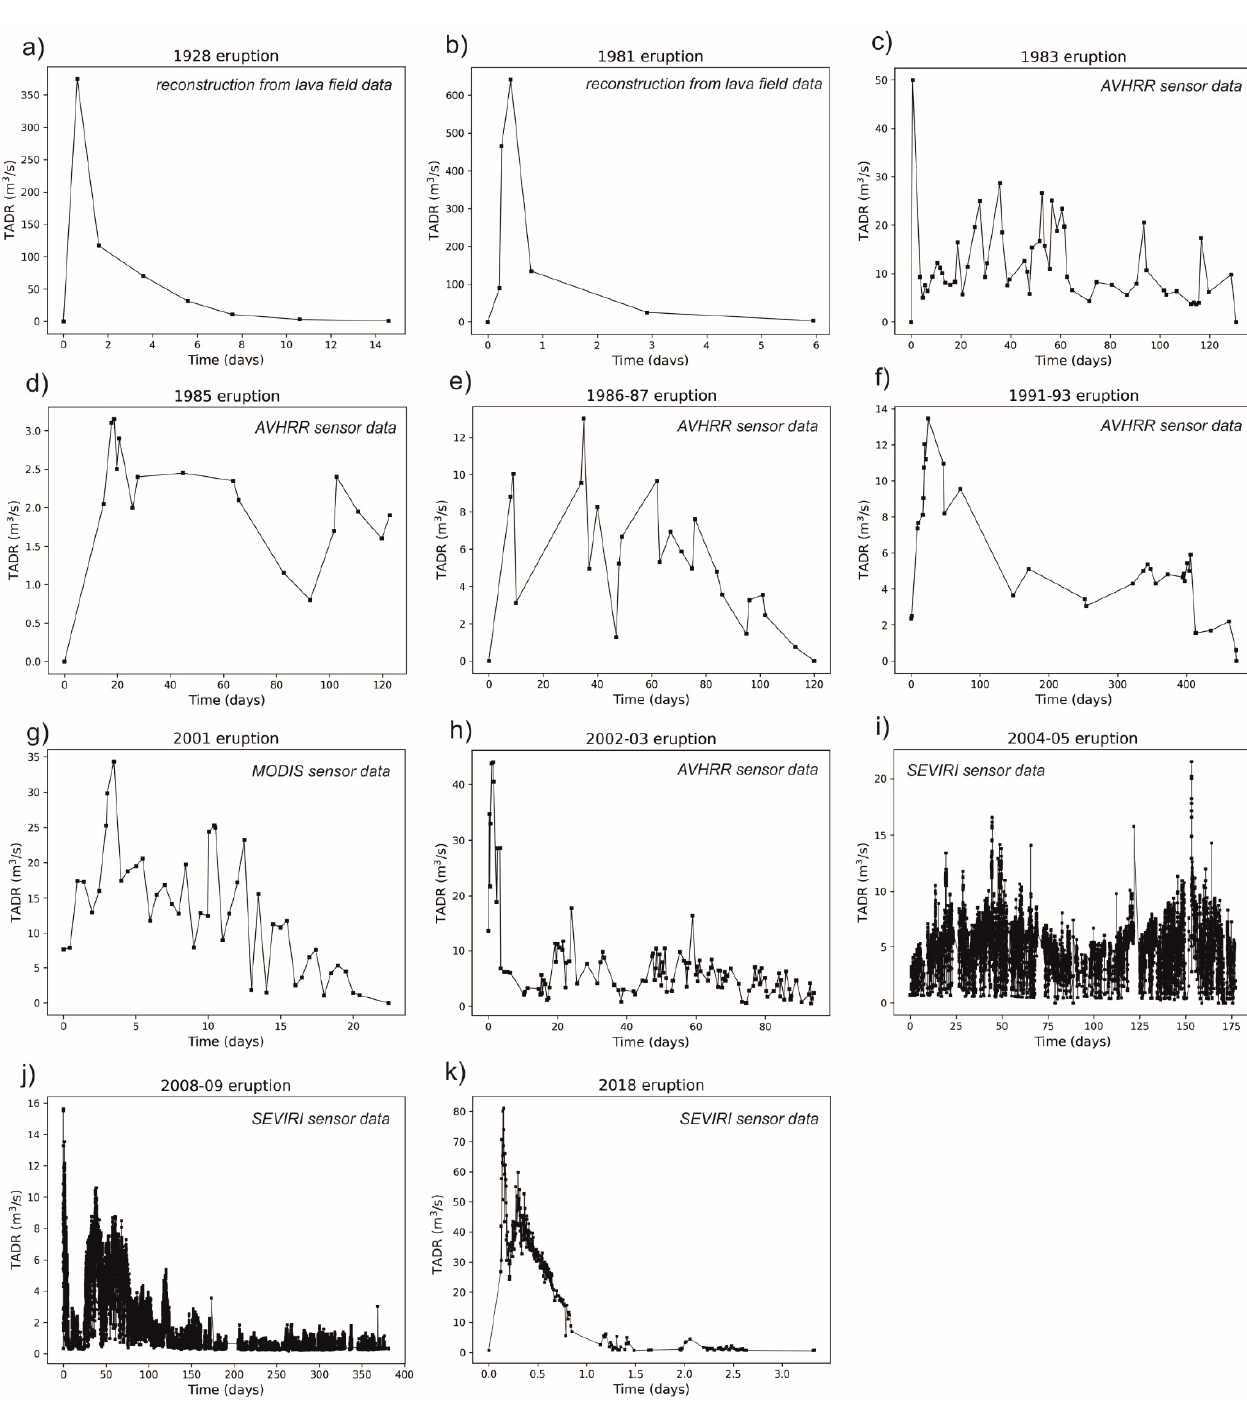
Figure 1. Estimated TADR time series related to the flank eruptions at Mt. Etna from field measurements ( a , b ), from AVHRR sensor ( c – f , h ), from MODIS sensor ( g ) and from SEVIRI sensor ( i – k ). See Table 1 for references.